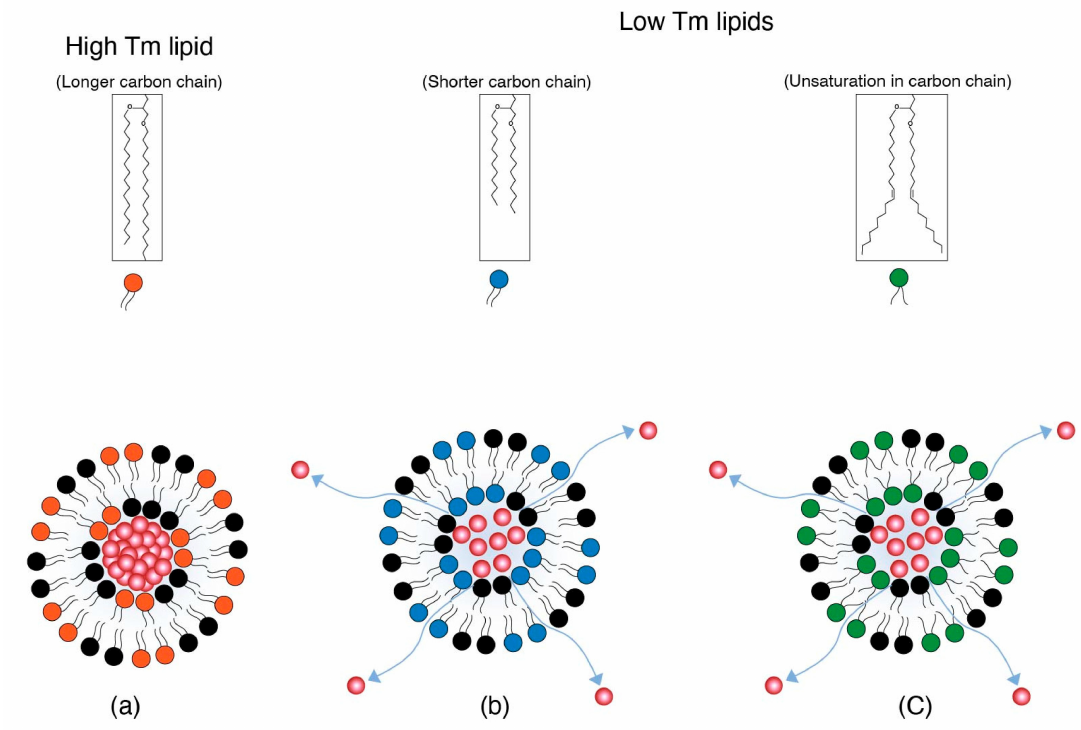
Figure 3. ( a ) An LNP with high Tm lipid represented by red head-group lipid keeps the drug cargo intact. ( b ) An LNP with low Tm lipid with a shorter carbon chain represented by blue head-group lipid and ( c ) An LNP with low Tm lipid with unsaturation represented by green head-group lipid. Both ( b ) and ( c ) impart more fluidic character to the LNP and thereby allow for more leakage of cargo from